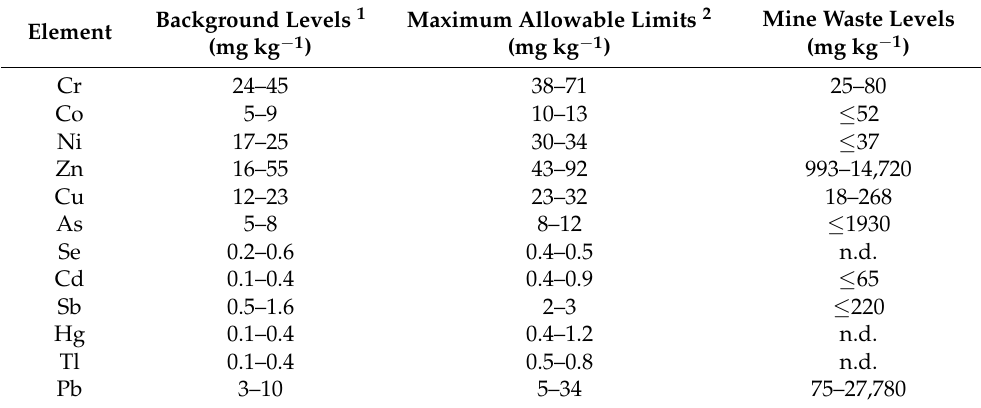
Table 3. Concentration ranges of some trace elements in soils of the region of Murcia [28] compared to the unusual values from the mine wastes of the Sierra Minera.